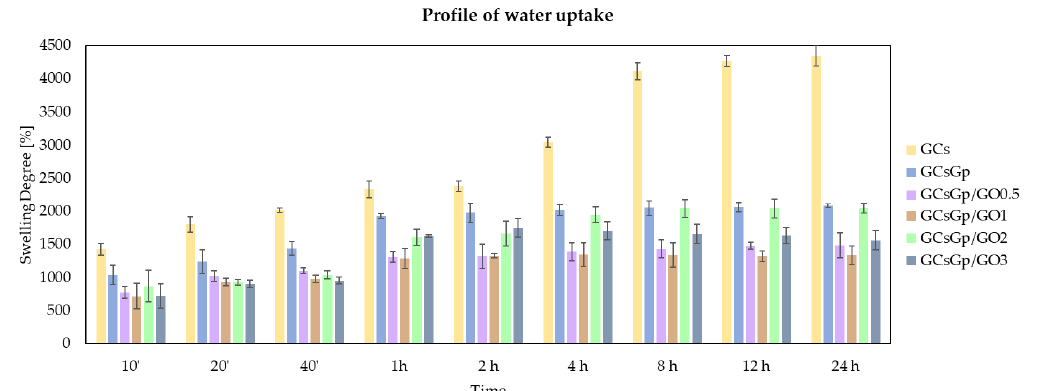
Figure 1. Swelling behavior of GCs, GCsGp, GCsGp / GO 0.5%, GCsGp / GO 1%, GCsGp / GO 2%, and GCsGp / GO 3%.